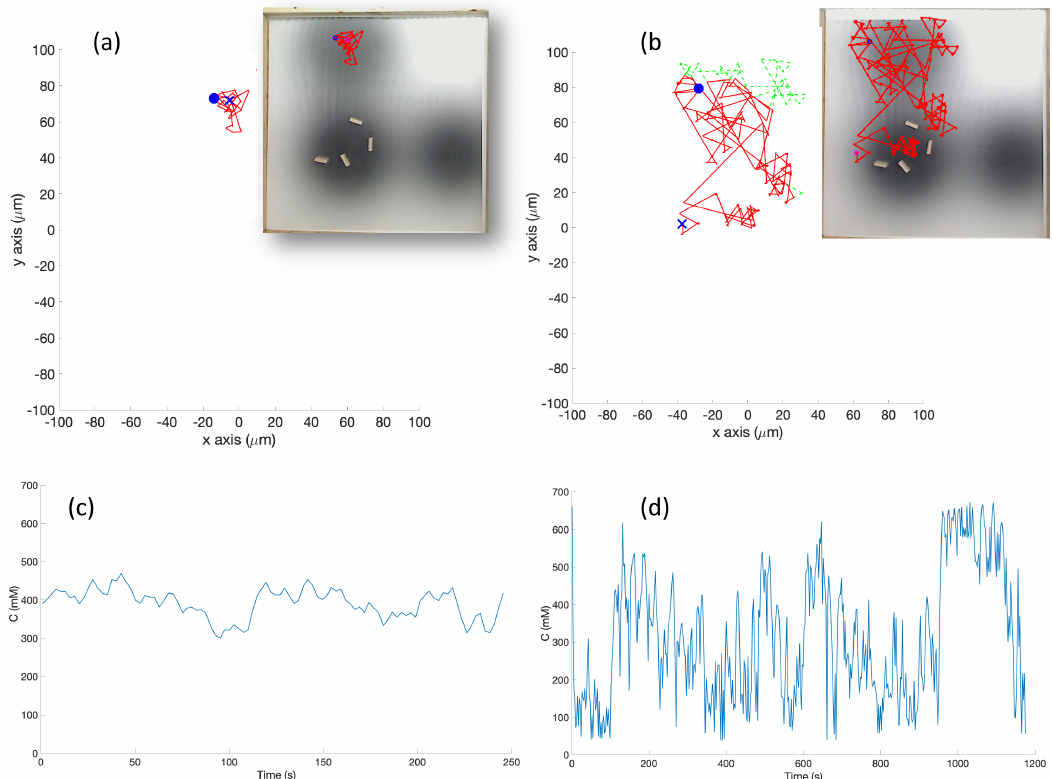
Figure 20. Case 11: With obstacles, in the triple-effluent environment, typical trajectories of the e-puck robot running ( a ) the basic chemotaxis controller, and ( b ) the RapidCell chemotaxis controller. In each trajectory, the initial position is shown as a blue circle and the terminal position is shown as a blue “X”. Positions corresponding to concentrations less than 1m M are shown in dashed green, otherwise shown in red. The recorded concentrations associated with each scheme are shown in ( c , d ) respectively.